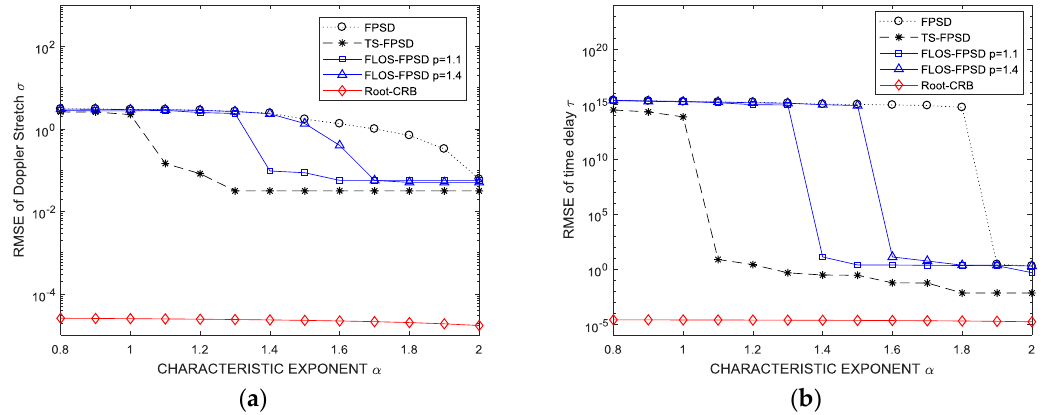
Figure 11. Estimation accuracy versus the characteristic exponent. ( a ) RMSE of the Doppler stretch; ( b ) RMSE of the time delay.